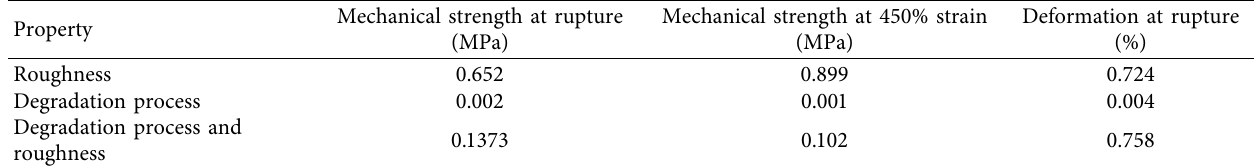
a Average of samples that reached 450% deformation. Table 4: ANOVA test comparing degradation process and roughness over mechanical strength (MPa) at 450% strain, mechanical strength (MPa) at rupture, and deformation at rupture.